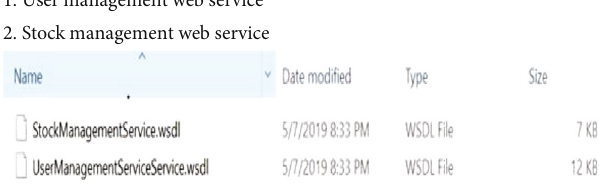
Figure 3: WSDL fi les for User Management and Stock Management web service.